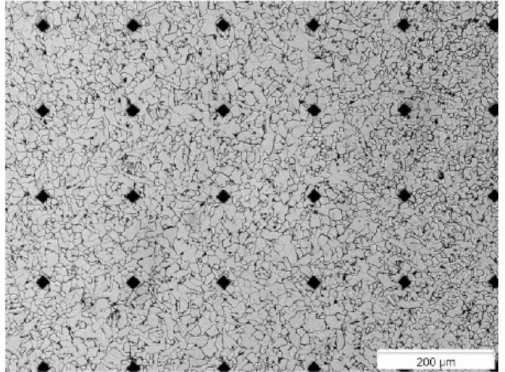
Figure 24. ER70S: Ferrite microstructure with small regions of perlite at the grain boundaries. Reprinted from Ref.